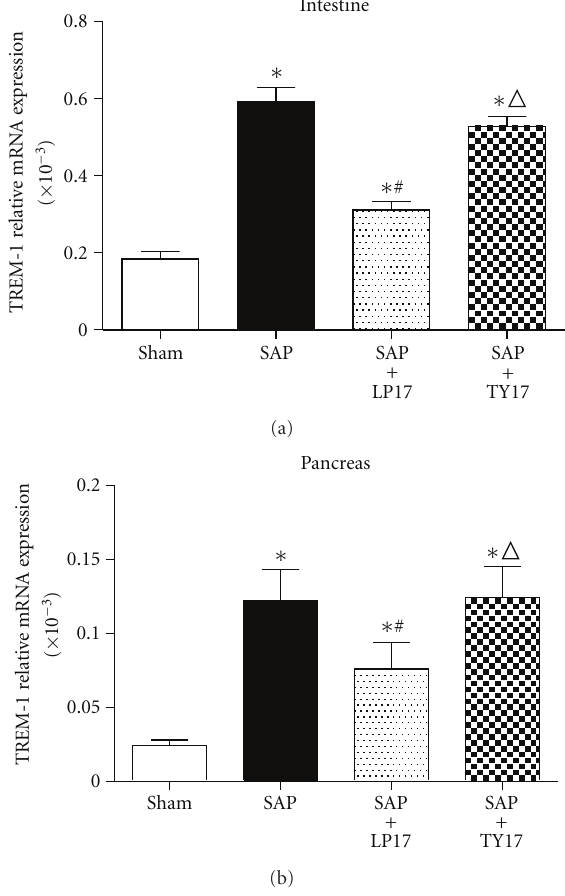
Figure 3: The expression of IL-1 β (a) and TNF- α (b) mRNA in the intestinal